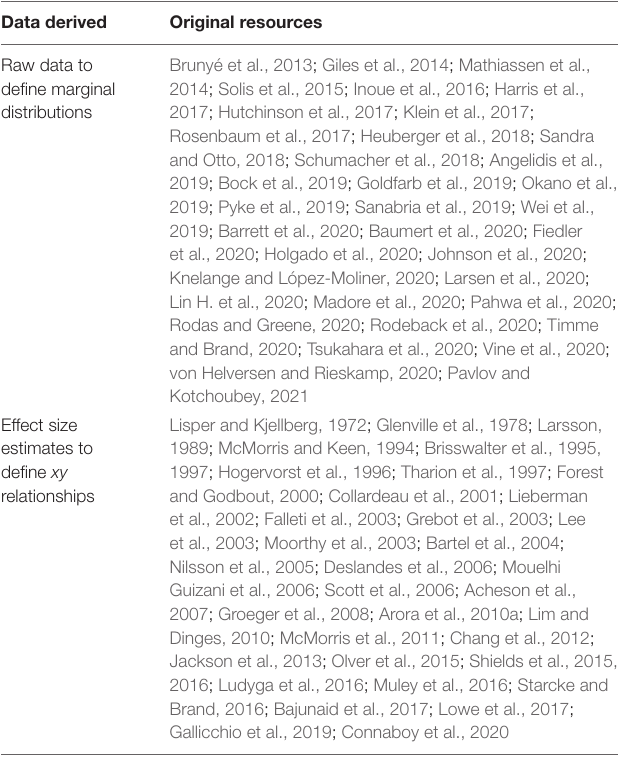
TABLE 1 | Original resources for deriving raw data to define marginal distributions (upper row) and effect size estimates to define xy relationships (lower row).